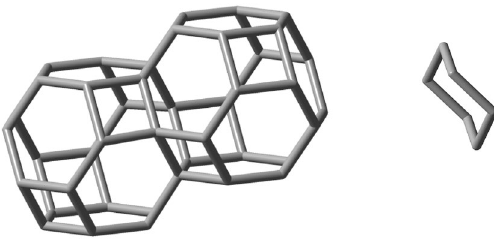
Figure 9. Left: Optimized geometry of the 1D-scaffold generator C 42 H 36 obtained from the linear hexagonal face-fusion of nugget 24a . Right: the released cyclohexane molecule. C 6 H 12 .